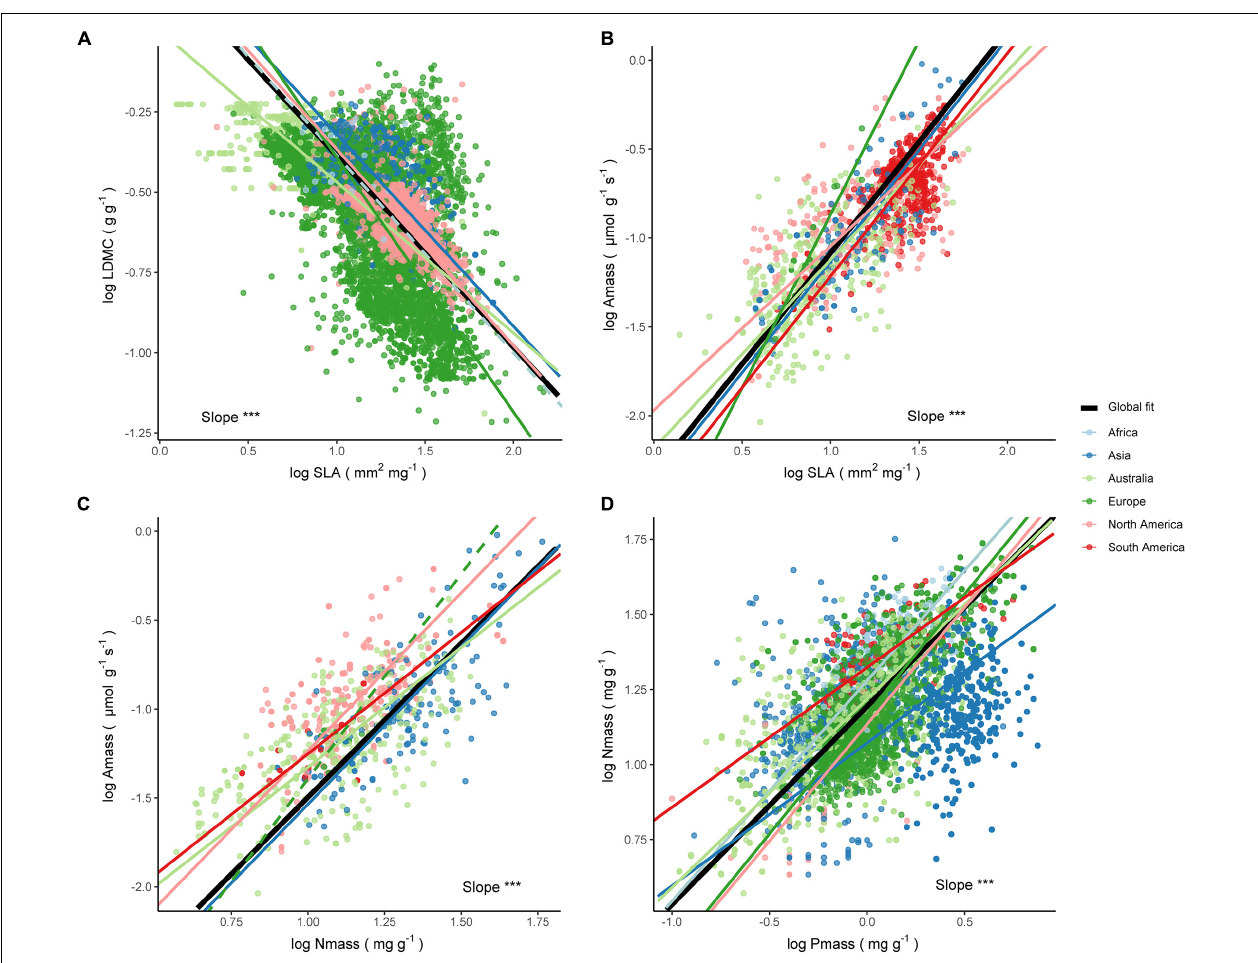
FIGURE 5 | Relationships between leaf economic traits across species within the Cf climate. The significance test results of the slope heterogeneity among the fitted lines are shown (*** P < 0.001). The solid line is a significant fit to the standardized major axis (SMA) regression within a continent, while insignificant relationships are shown as dashed lines. Black solid lines are SMA regression lines for all species on a global scale. The respective slopes, sample sizes, and coefficients of determination of the SMA regressions are as follows (all P < 0.001 unless noted): (A) LDMC–SLA relationship. Africa: b = − 0.61, n = 18, R 2 = 0.01, P = 0.67; Asia: b = − 0.6, n = 1304, R 2 = 0.37; Australia: b = − 0.47, n = 533, R 2 = 0.49; Europe: b = − 0.79, n = 9796, R 2 = 0.33; North America: b = − 0.61, n = 2564, R 2 = 0.48. (B) A mass –SLA relationship. Asia: b = 1.25, n = 155, R 2 = 0.63; Australia: b = 1.06, n = 331, R 2 = 0.37; Europe: b = 1.95, n = 24, R 2 = 0.87; North America: b = 0.92, n = 307, R 2 = 0.34; South America: b = 1.25, n = 516, R 2 = 0.46. (C) A mass –N mass relationship. Asia: b = 1.77, n = 149, R 2 = 0.57; Australia: b = 1.35, n = 326, R 2 = 0.4; Europe: b = 2.3, n = 13, R 2 = 0.06; North America: b = 1.78, n = 310, R 2 = 0.4; South America: b = 1.37, n = 21, R 2 = 0.31, P = 0.01. (D)